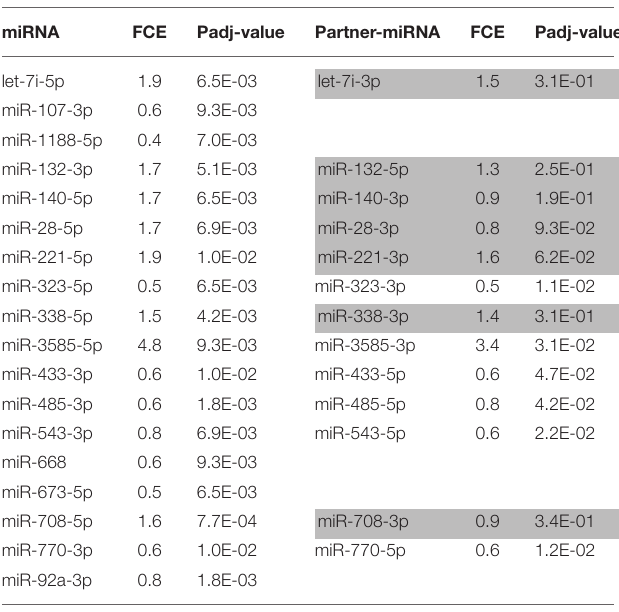
Eighteen miRNAs displayed expression differences with padj-values = < 1.0E-2 between groups C-C and HF-C. Ratios of HF-C to C-C expressions (Fold-Changes of Expression; FCEs) are expected to occur with similar levels and associated padj-values for the miRNAandsecondstrand(Partner-miRNA)derivedfromthesameRNAduplexprecursor. Thirteen miRNAs were identified along with their Partner-miRNAs. Six Partner-miRNAs, i.e., miR-323-5p, − 3585-5p, − 433-3p, − 485-3p, − 543-5p, and − 770-3p